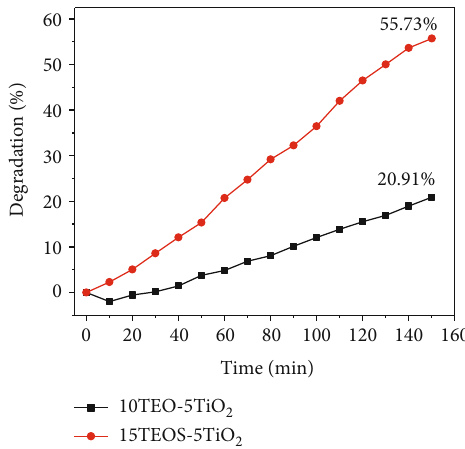
Figure 3: Photodegradation curves of methyl orange with di ff erent photocatalyst: 10TEOS-5TiO (red line).